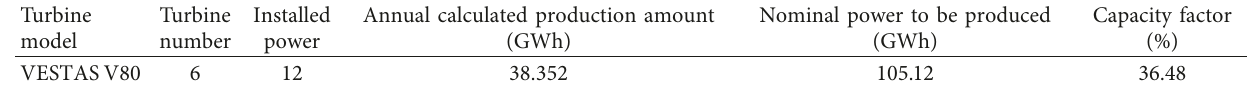
Table 5: Capacity factor of the area.